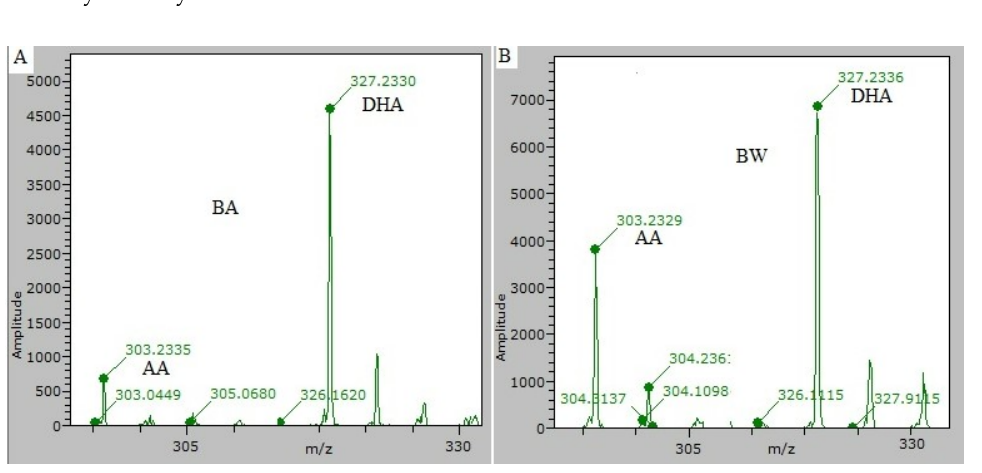
Figure 1. [DHA-H] − and the [AA-H] − mass spectrum obtained from farmed (BA) ( A ) and wild (BW) ( B ) sea bass, respectively. Errors in mass identification were less than 2 ppm and scores were higher than 0.71.